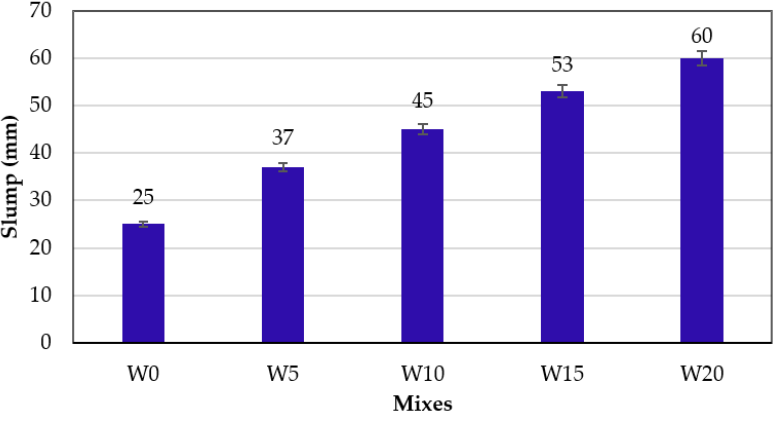
Figure 7. Comparison of the slump of different concrete mixes.